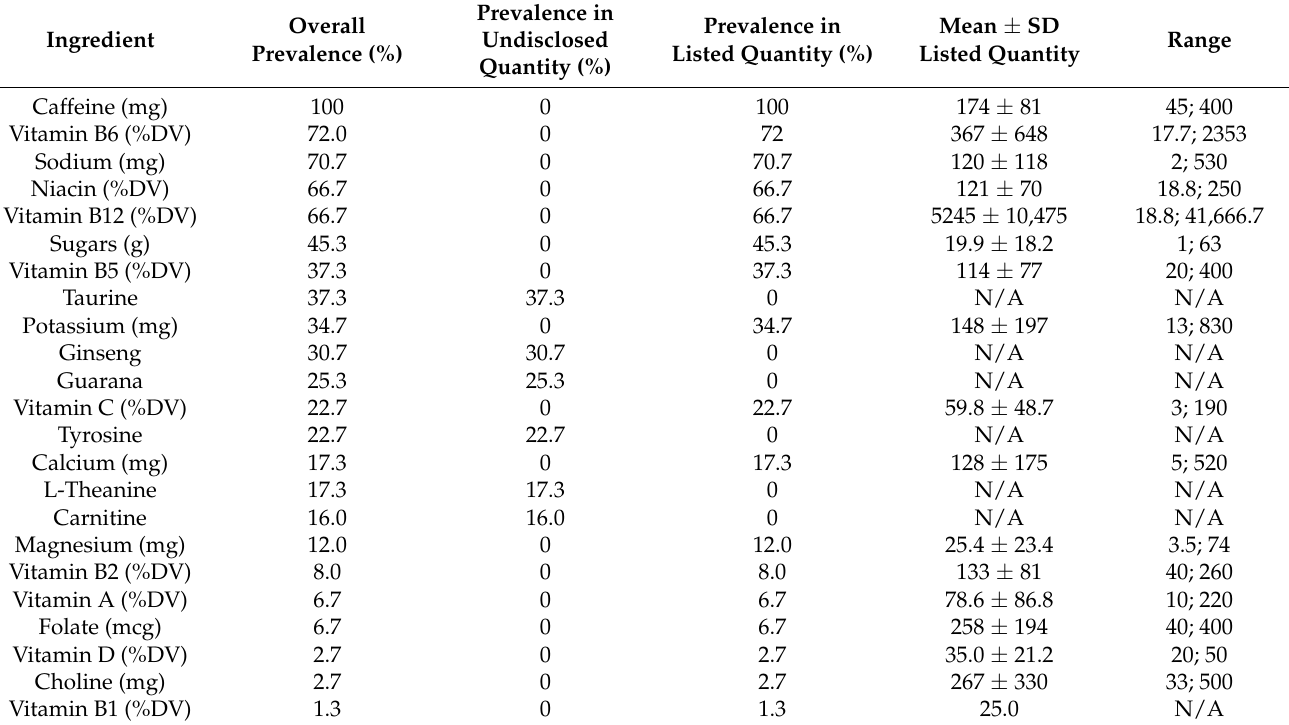
Table 1. Prevalence and quantities of ingredients included in the bestselling energy drinks and energy shots ( n = 75) per serving